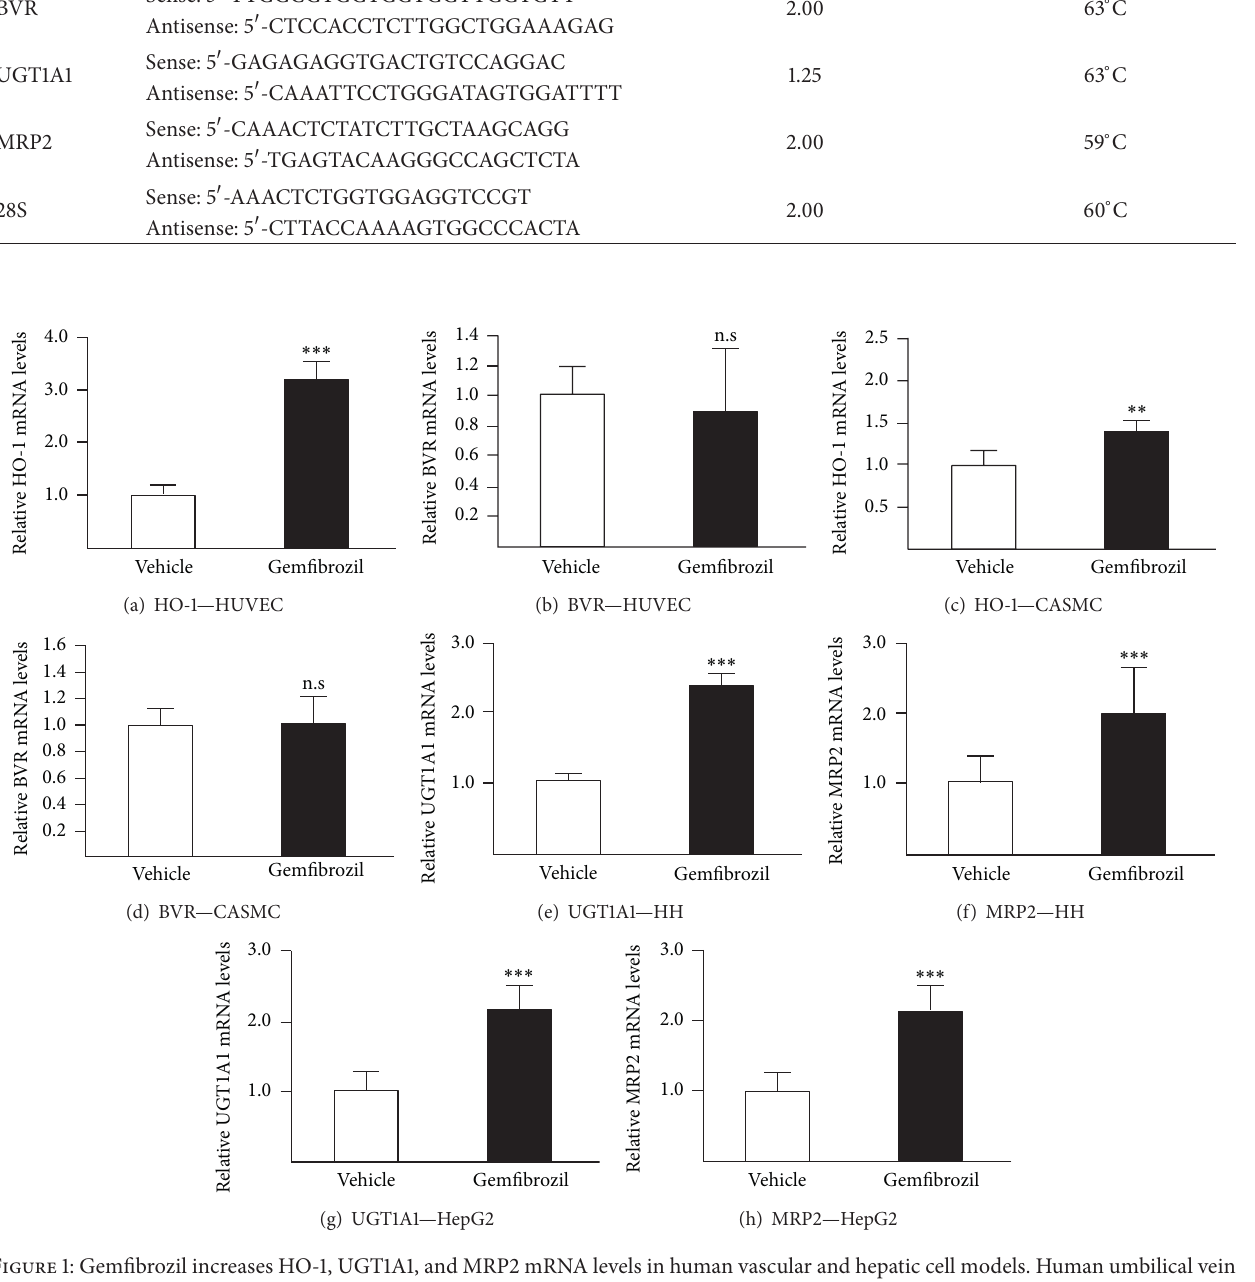
Figure 1: Gemfibrozil increases HO-1, UGT1A1, and MRP2 mRNA levels in human vascular and hepatic cell models. Human umbilical vein endothelial cells (HUVEC) (a and b), coronary artery smooth muscle cells (CASMC) (c and d), and HepG2 cells (g and h) were treated with vehicle (DMSO, 0.1%, v/v) or gemfibrozil (250 𝜇 M) for 24 H. Human hepatocytes (HH) from donor 1 (e and f) were treated with vehicle (DMSO, 0.1%, v/v) or gemfibrozil (200 𝜇 M) for 24 H. Transcript levels were quantified from total RNA through quantitative RT-PCR analyses and normalized with the housekeeping RNA 28S. Values (mean ± SD) are expressed relatively to control (vehicle) set at 1. Statistically significant differences between vehicle- and gemfibrozil-treated cells are indicated by asterisks (Student’s 𝑡 -test: ∗∗ 𝑃 < 0.01 ; ∗∗∗ 𝑃 < 0.001 ; n.s: